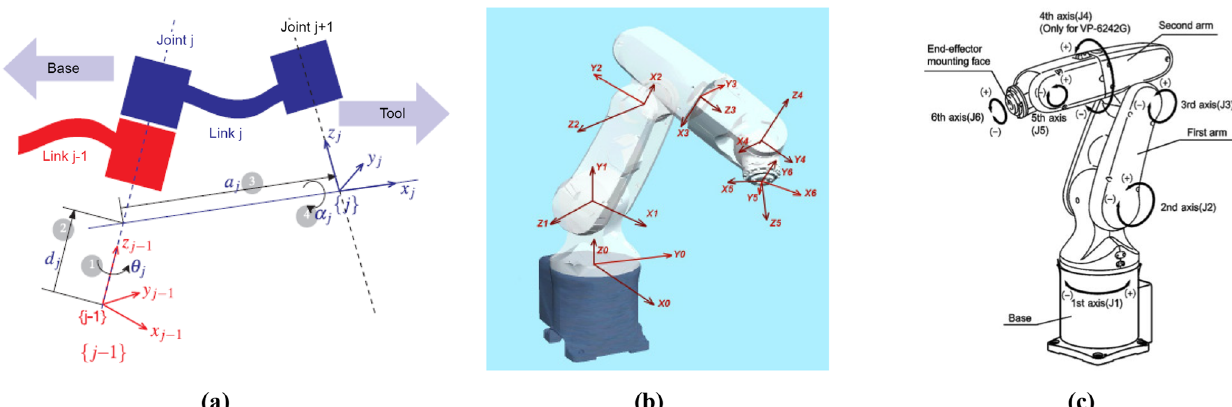
Figure 5. DH representation of a joint–link combination (Corke, 2011) world frame and joint frames (Quanser, 2018), axes of the Denso robot (Denso Robotics, 2018).